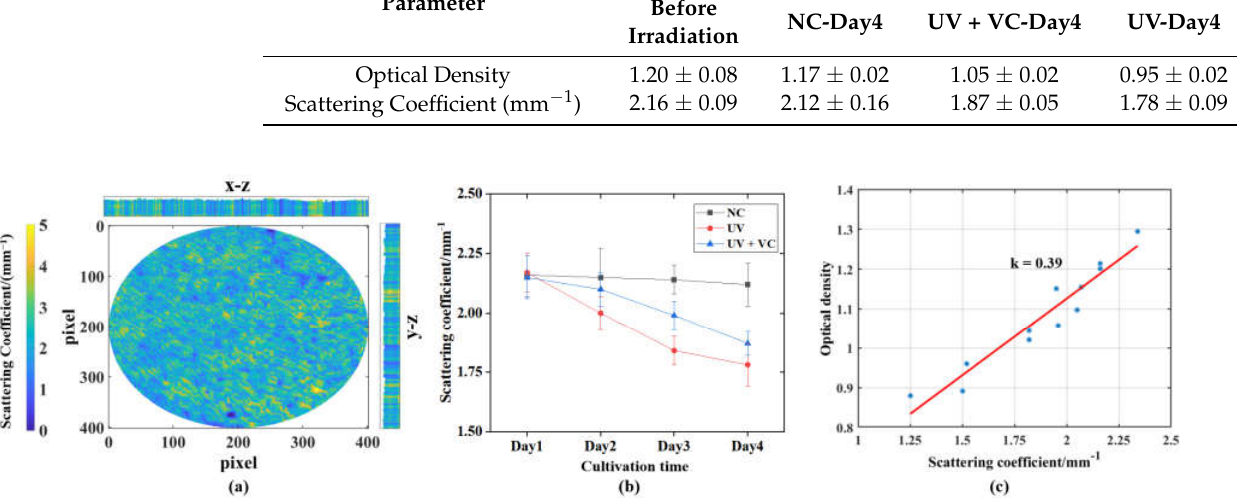
Figure 9. ( a ) The 2D distribution of scattering coefficients and B-scan scattering coefficient distribution in the x-z and y-z directions past the AS centroid; ( b ) OCT imaging characterizing the variation in scattering coefficients for each group of AS with incubation time and irradiation dose; ( c ) linear fit of scattering coefficients and optical density. Table 2. Scattering coefficient and MTT experimental results.